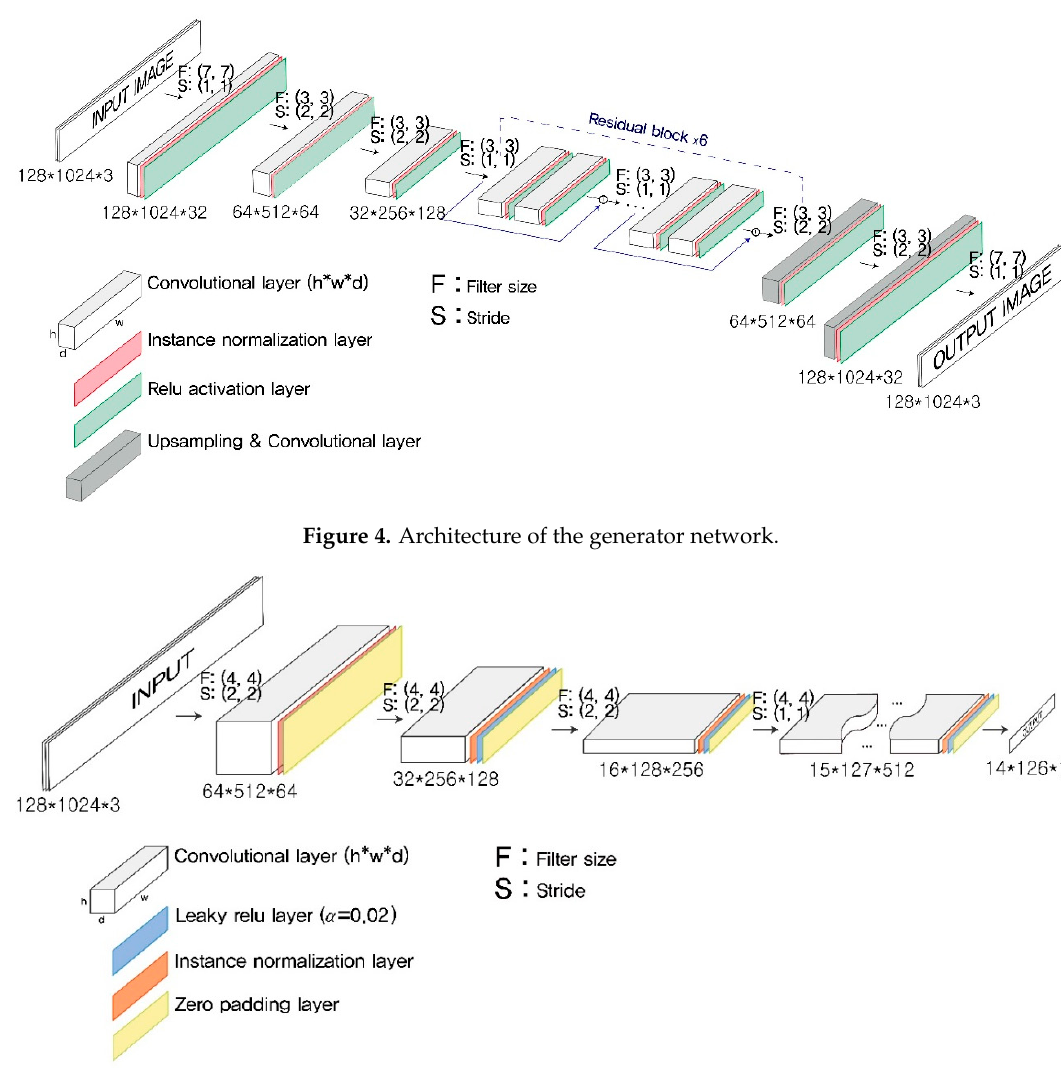
Figure 4. Architecture of the generator network.